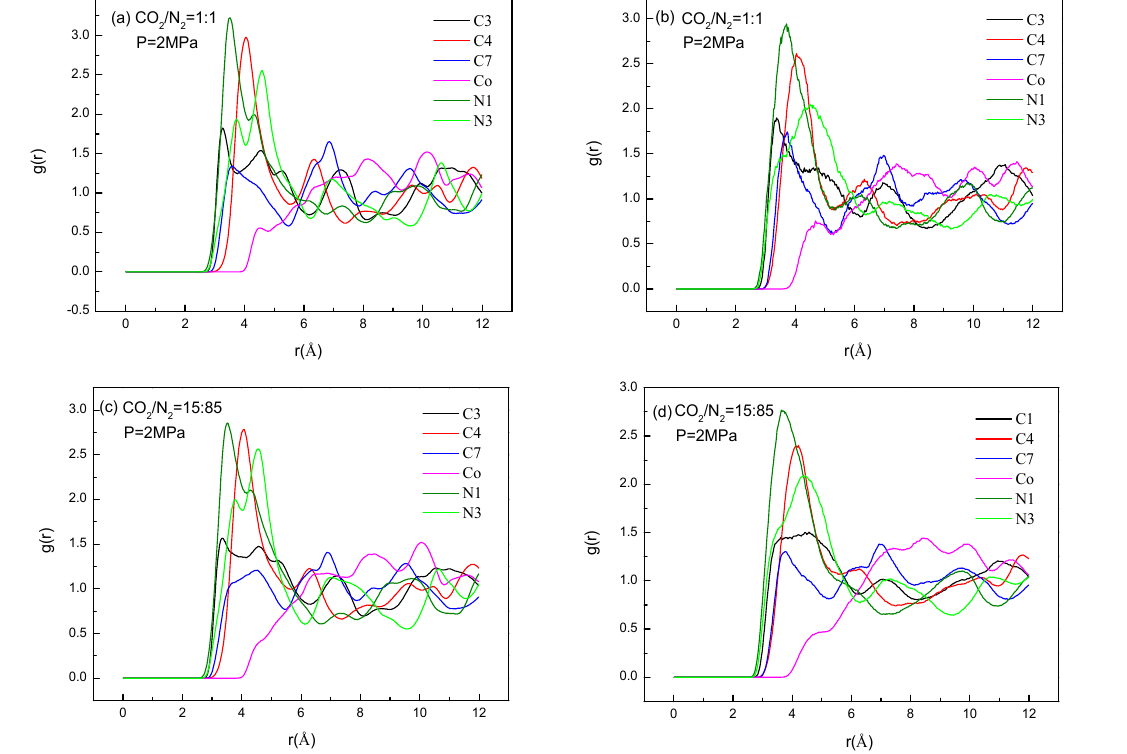
Figure 4. Radial distribution functions of ( a ) CO 2 and ( b ) N 2 from equimolar binary mixtures of CO 2 /N 2 ; and radial distribution functions of ( c ) CO 2 and ( d ) N 2 from 15:85 binary mixtures of CO 2 /N 2 around framework atoms at 2 MPa.